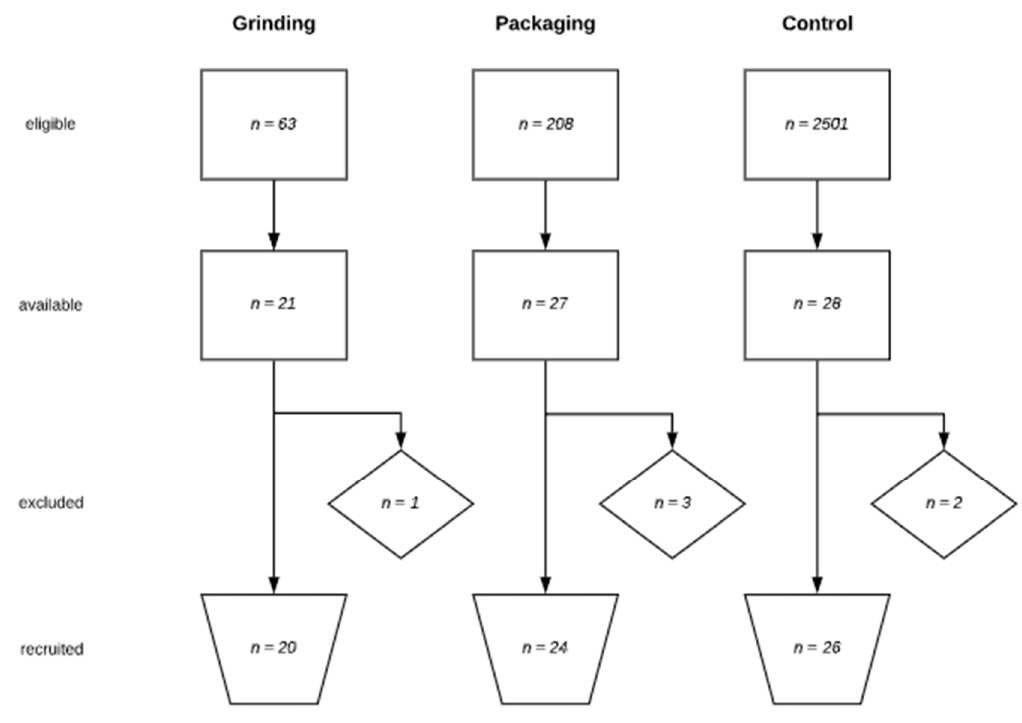
Figure 3. Study population flowchart.